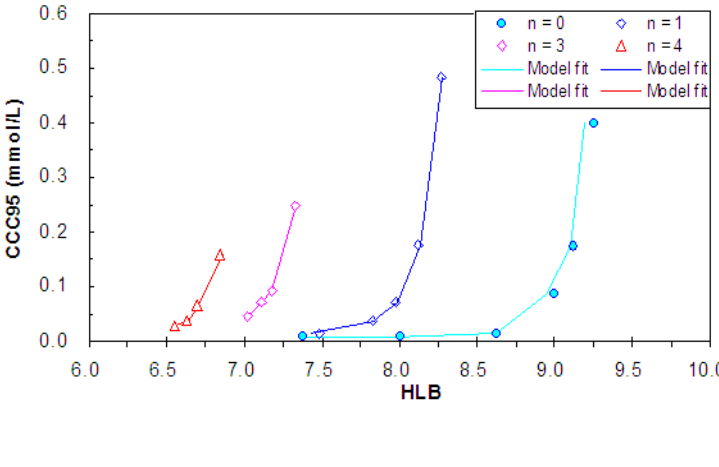
Figure 11. Model (Equation (12)) fit CCC95 versus HLB data for the Polyglycols plotted as function of m for a given